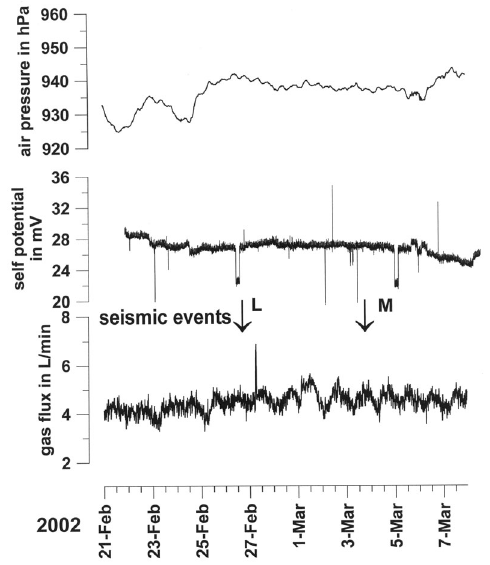
Fig. 6. Temporal variation of the gas flux and at- mospheric pressure recorded at the Tramutola station and the self potential signal recorded at Marsico Nuo- vo in the period from February 21 to March 7, 2002. L and M are local seismic events in that period.